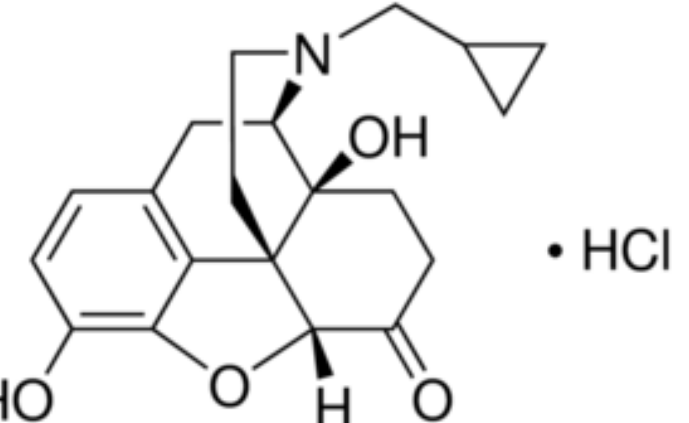
Figure 1. Structural formula of Naltrexone hydrochloride.